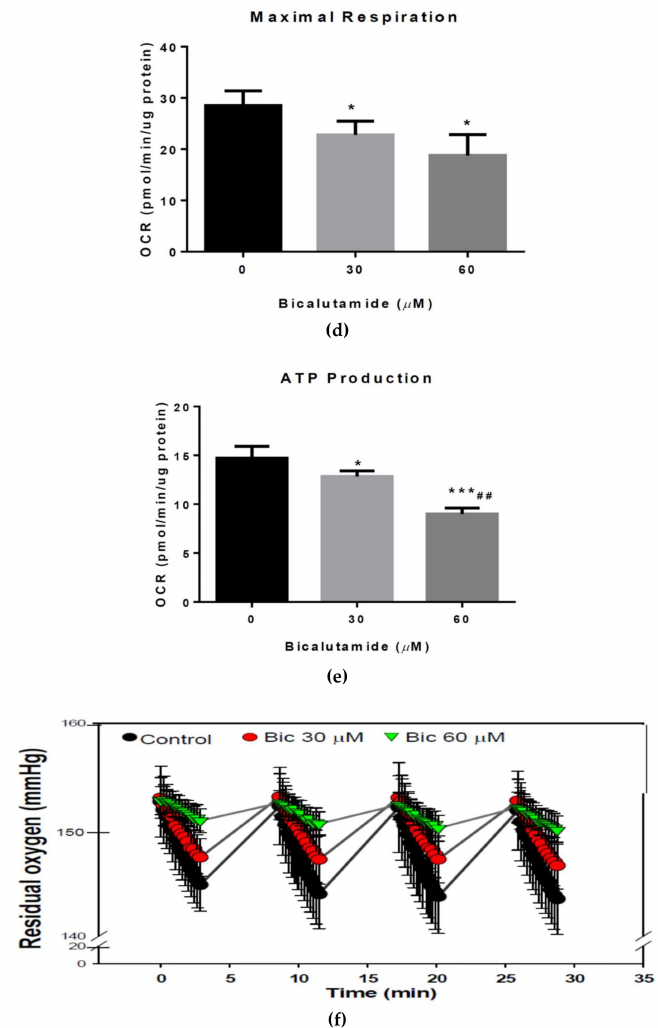
Figure 4. Parameters of the mitochondrial oxygen consumption rate (OCR) and residual oxygen a ff ected by bicalutamide (Bic). Rat mesangial cells (RMCs) were untreated or treated with Bic at doses of 30 and 60 µ M for 24 h. The basal respiration, maximal respiration and ATP production in cells all decreased. More residual oxygen consumption (ROX) remained at the higher dosage of Bic. ( a ) Time course and OCR curve plot obtained by a Seahorse analyzer. Quantification of changes in parameters induced by Bic treatment included ( b ) basal respiration, ( c ) proton leakage, ( d ) maximal respiration, ( e ) ATP production and ( f ) time course of residual oxygen in RMCs untreated or treated with Bic at 30 and 60 µ M. Data are expressed as the mean ± standard deviation ( n = 3). * p < 0.05, ** p < 0.01, *** p < 0.005 compared to untreated cells; # p < 0.05, ## p < 0.01 compared to 30 µ M Bic-treated cells. When electron transport chain inhibitors are added, residual oxygen consumption (ROX) is due only to non-mitochondrial respiration caused by some oxidases and other cellular enzymes [69]. ROX was increased by Bic therapy in a dose-dependent manner (Figure 4f). As seen, after treatment with 30 µ M Bic, the value remained high at 145.5 mmHg until 20 min but declined to 143.2 mmHg at 27 min. A higher dose (60 µ M) of Bic yielded a higher ROX, which was suppressed from 151 mmHg (at 3 min) to 150 mmHg at 27 min (Figure